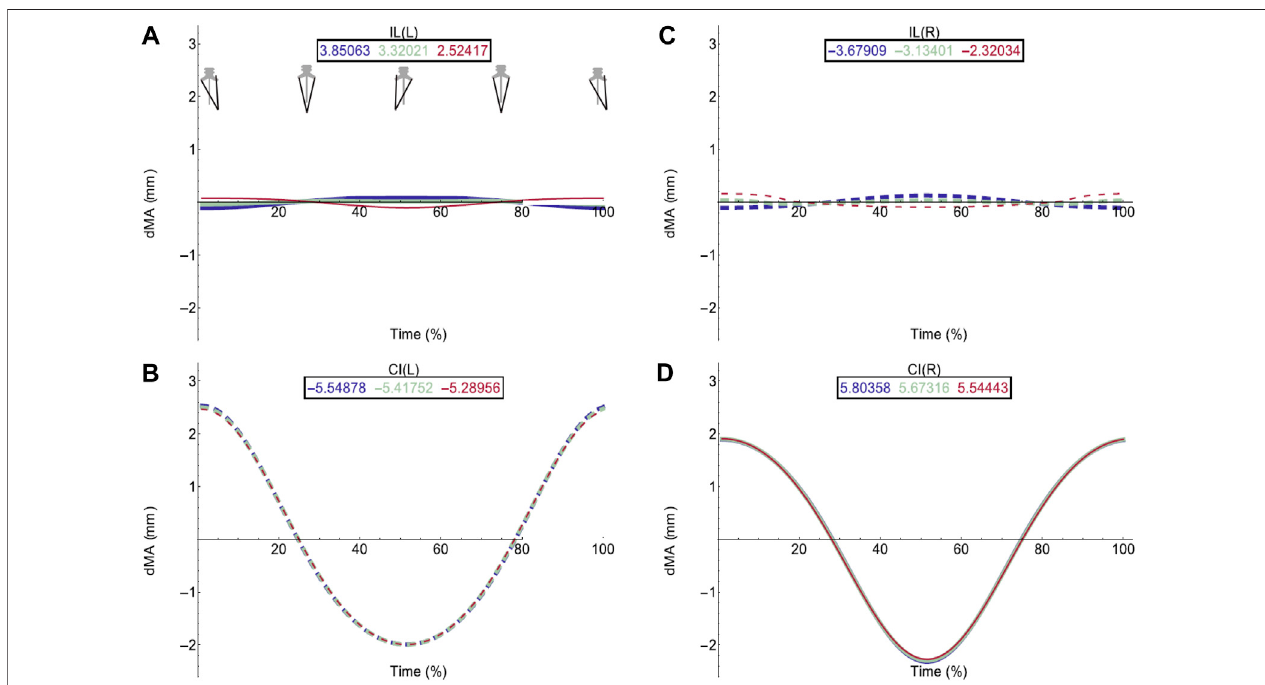
FIGURE 4 | Effect of pelvic rotation on axial muscle moment arms. Changes in moment arm (dMA) versus time are shown for (A) the left Iliolumbaris, IL (L), (B) left coccygeoiliacus,CI(L), (C) rightIliolumbaris,IL(R), (D) rightcoccygeoiliacus,CI(R).Schematiciconsindicatethepositionofthepelvismovingsinusoidallyfromright(time 0%) to centre (25%) to left (50%) to centre (75%) to right (100%). For each muscle, three hypothetical conditions were run: dorso-ventral iliosacral joint in the extended position (blue), half- fl exed (light green) and fully fl exed (red). For all conditions, the femur is held at 10 ° whilst all other joints are held at zero degrees. Traces are shown as changes relative to the mean moment arm (see Methods) such that positive versus negative values indicate de fl ection above versus below the mean. Boxed values show the mean moment arm value for each condition with colours corresponding to the respective Δ MA plots. Solid versus dashed lines represent positive moment arms ( fl exion — lateral rotation to the left) versus negative (extension — lateral rotation to the right) such that a change from solid to dashed indicates a change in muscle function. Moment arms for abduction/adduction and long-axis rotation are in